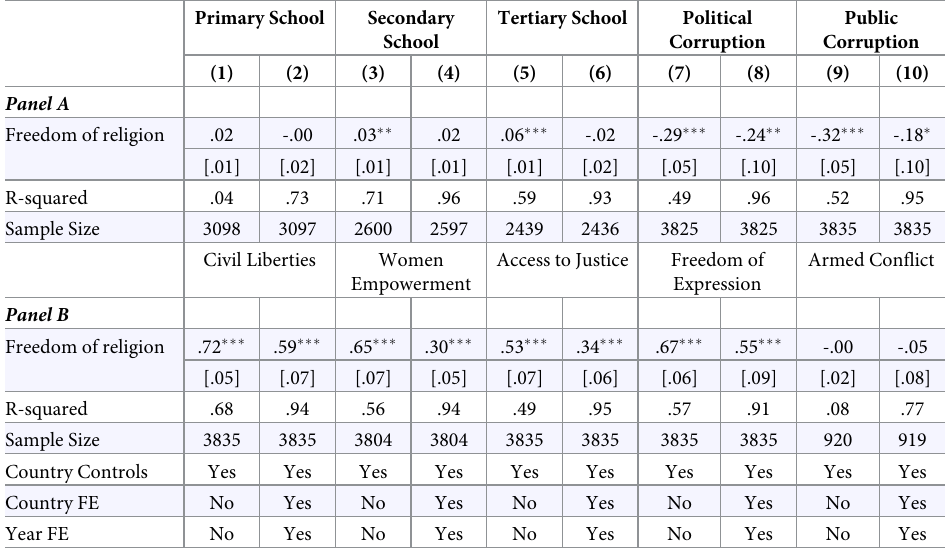
Table 6. Examining the mechanisms behind the effects of religious liberty on well-being.